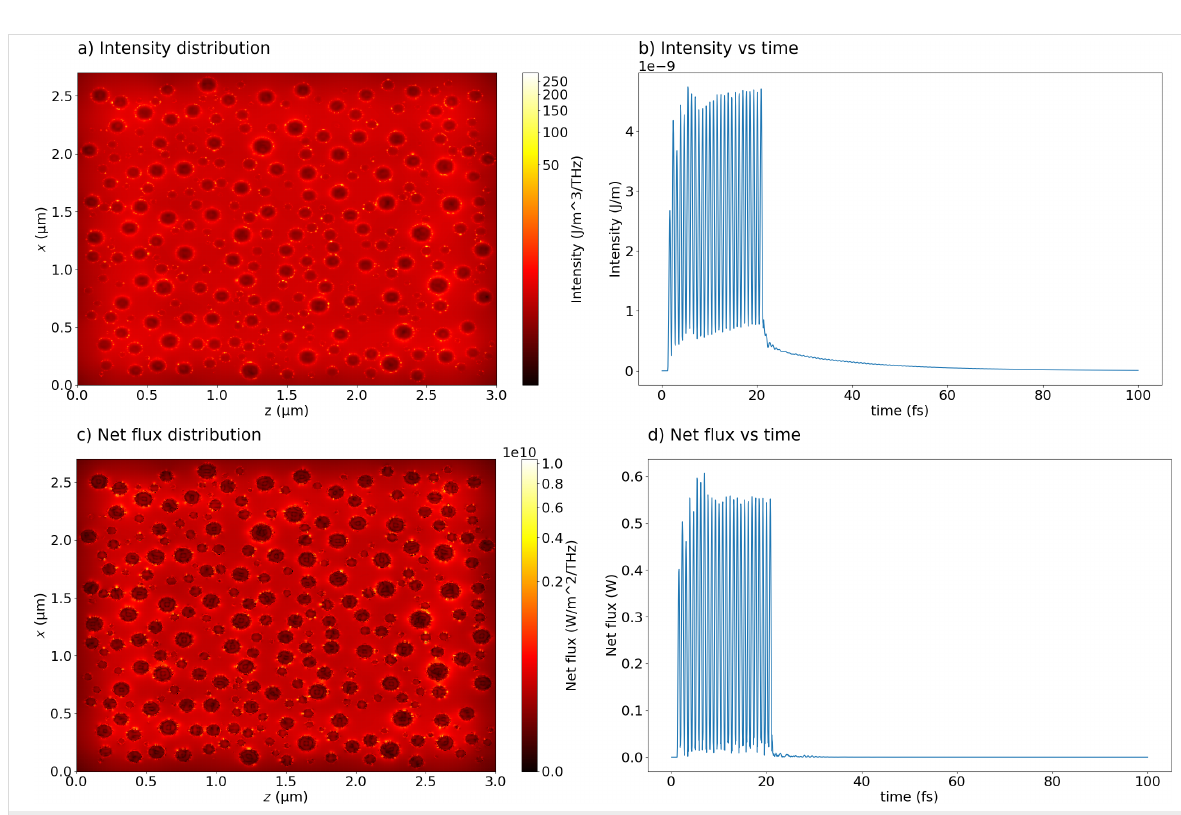
Figure 13: a) Calculated intensity distribution of the electromagnetic field integrated on the plane where nanoparticles are placed; b) intensity ampli- tude as a function of the time; c) calculated net flux (transmission minus reflection); d) net flux amplitude as a function of the time. The incident light at wavelength 460 nm is